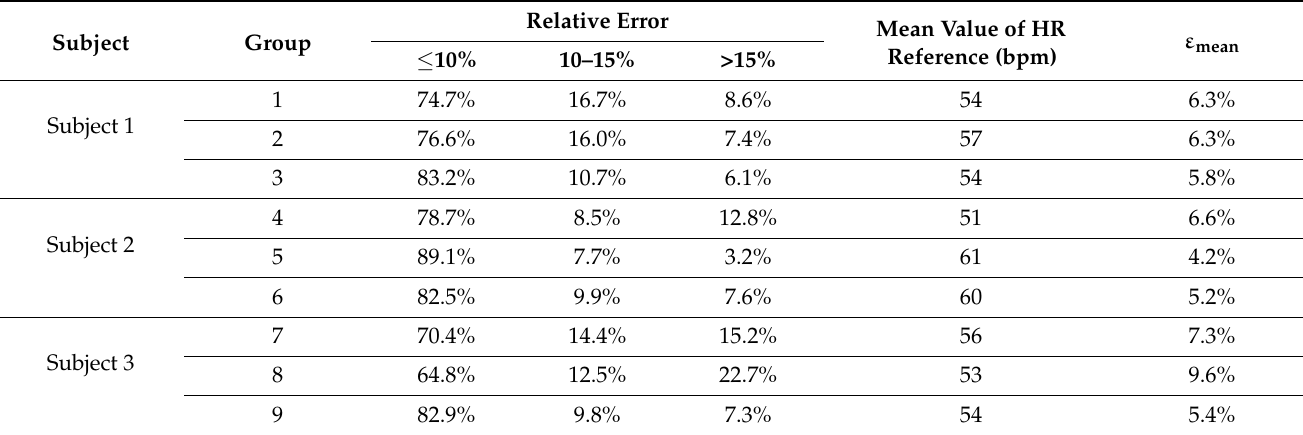
Table 2. The proportions of 6 h night sleep HR detection data errors compared to the true value for the three